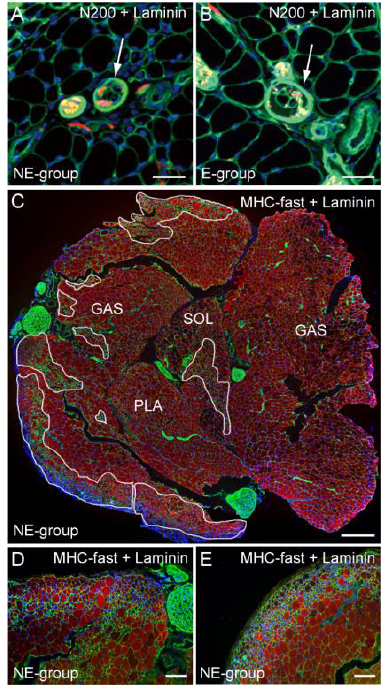
Figure 4. Detection of muscle spindles and pathological muscle fiber area. Typical muscle spindle in the NE ( A , arrow) and E ( B , arrow) group stained with N200 (red) and laminin (green). Both spindles are innervated, but irregular fiber diameters and central nuclei are observed in the NE group; ( C ) Detail of the pathological muscle fiber area in the whole muscle cross-section (GAS, PLA, SOL) stained with anti-myosin heavy chain (MHC) fast type (red) and laminin (green). These enclosed areas account for 17% as pathological area. A higher magnification of the typical pathological muscle fiber features is shown in ( D , E ). Severe irregular fiber diameters are evident. Blue staining in each panel is the nuclear staining of DAPI. Bars in ( A , B ) = 50 µ m, ( C ) = 200 µ m, and ( D , E ) = 100 µ m.